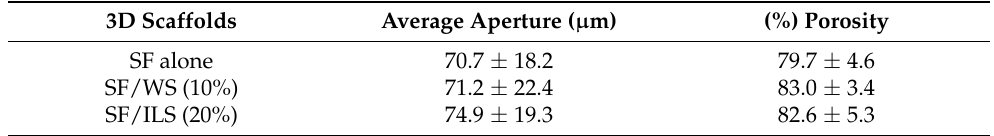
Table 4. Average pore size and porosity of SP composite